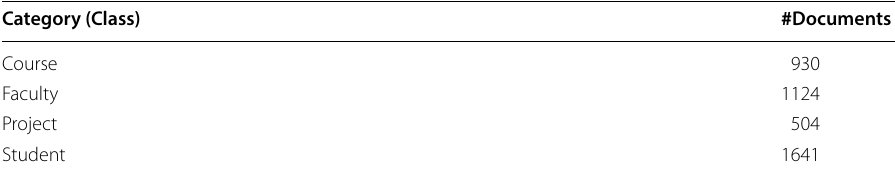
Table 5 Category distribution for the WebKB collection